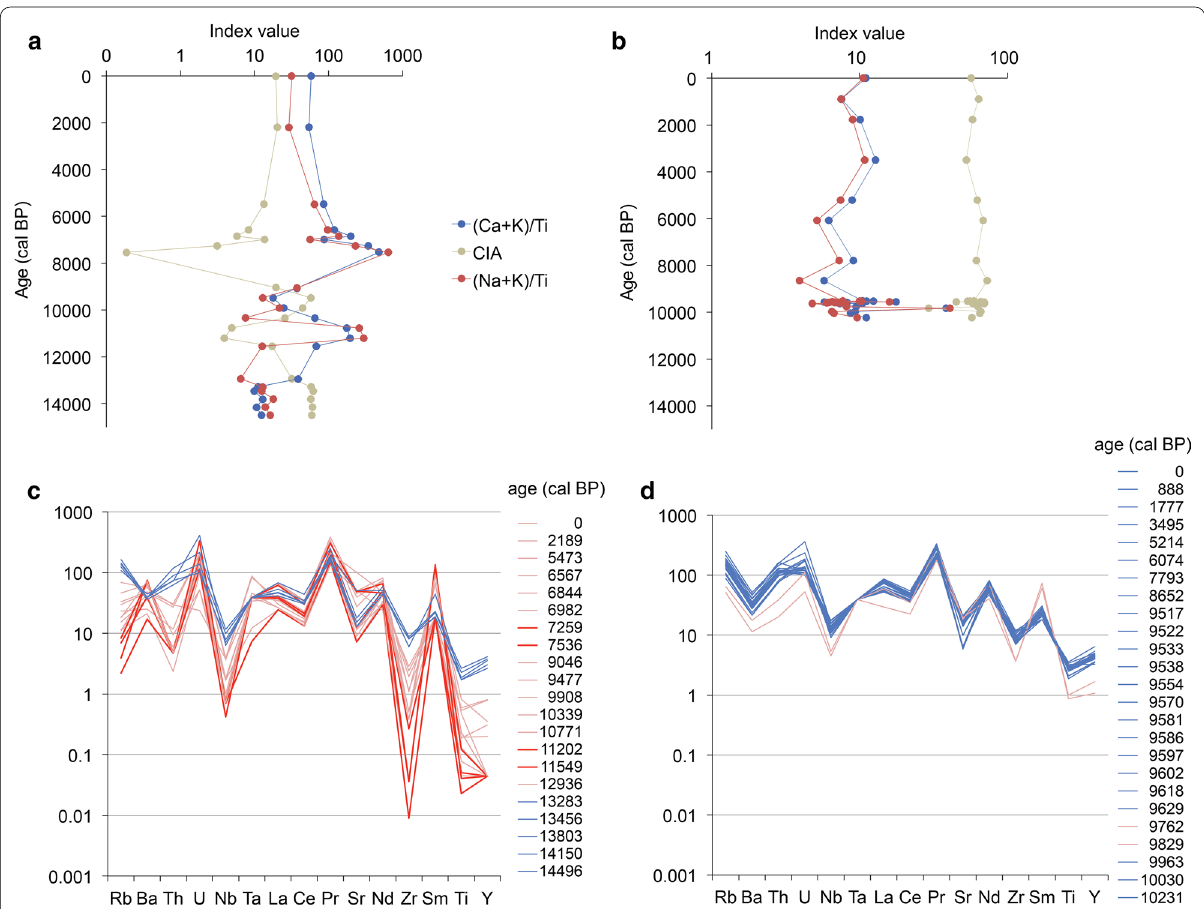
Fig. 10 Chemical weathering indices a at site 1 (former lake) and b at site 4 (plain; Grosses Moos). Primitive mantle (Sun and McDonough 1989) normalised data of trace elements as a function of time (interpolated data from the measured 14 C data; see Fig. 6) c at site 1 (former lake) and d at site 4 (plain). The ages are